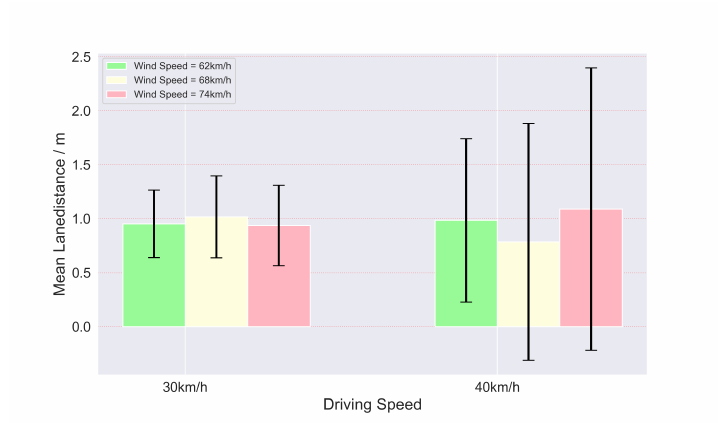
Figure 21. Lateral displacement values for different wind and driving